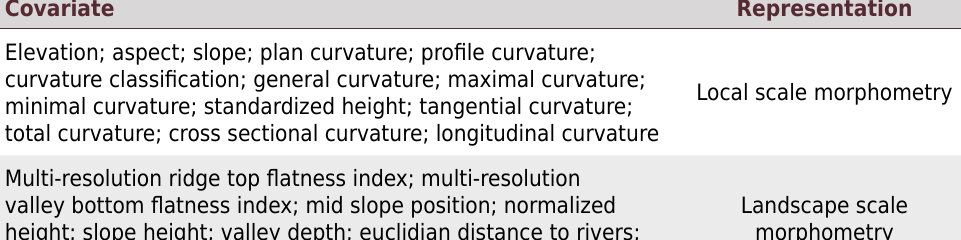
Table 2. Covariates derived from a 10 m DEM, from the distances calculation and the geographic position and its representation